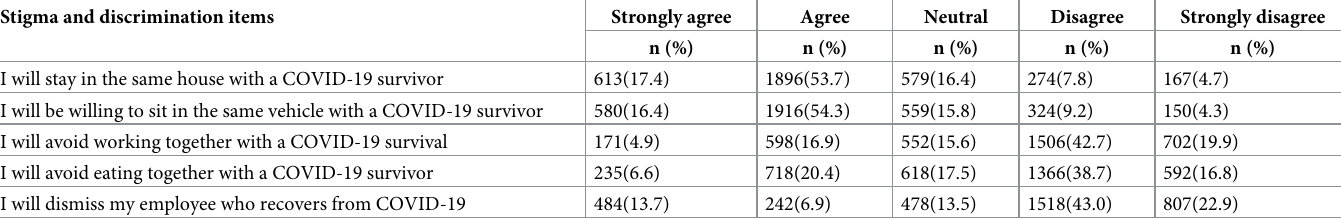
Table 4. Stigma and discriminatory tendencies towards COVID-19